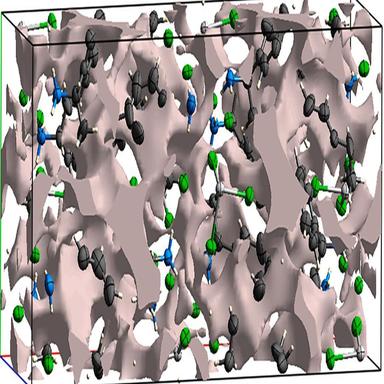
3D graphical view of voids in the crystal packing of (C8H12N)42.